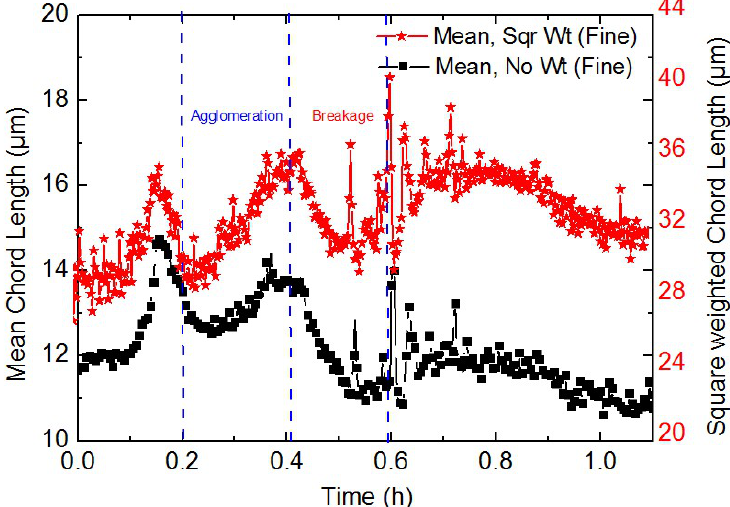
Figure 7. Variation trends of chord length during the hydrate slurry dissociation (5 MPa, 25% water-cut).